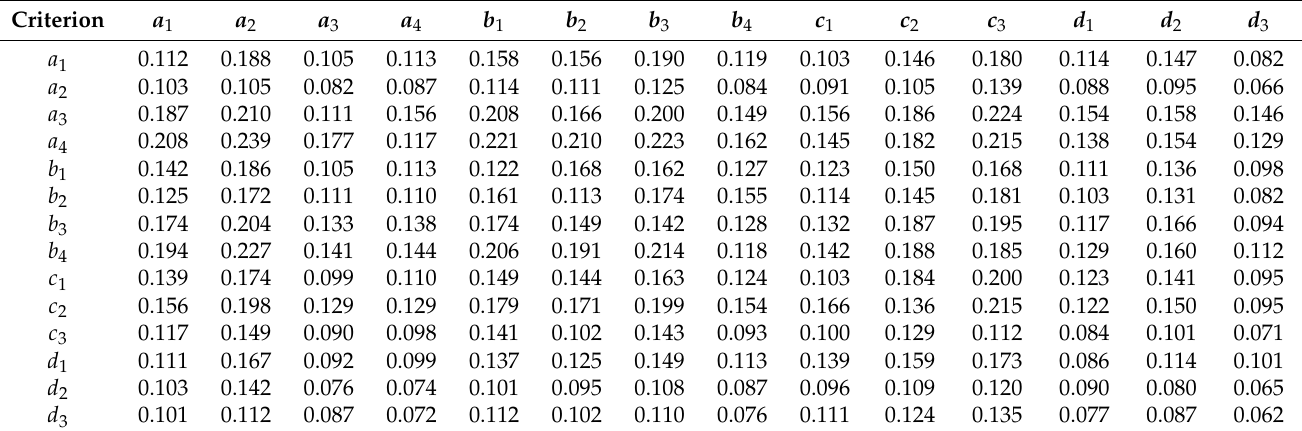
Table 8. Fuzzy normalized direct and indirect influence relation matrix T for the criteria (average).